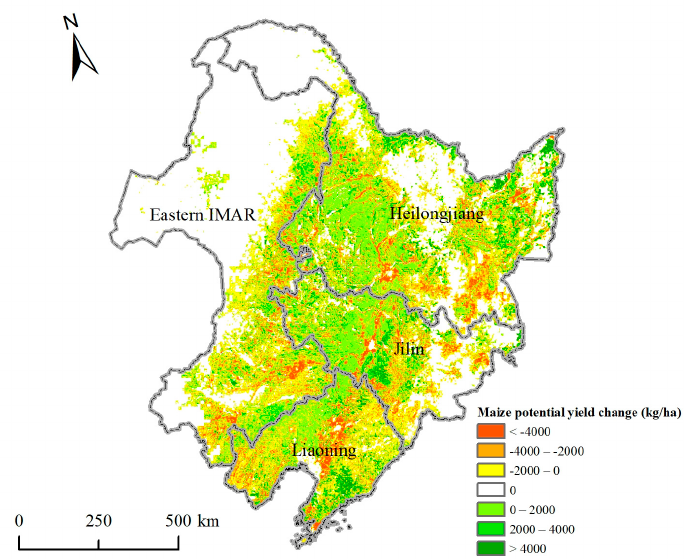
Figure 9. Spatial changes of maize potential yields in Northeast China during 2015–2050.